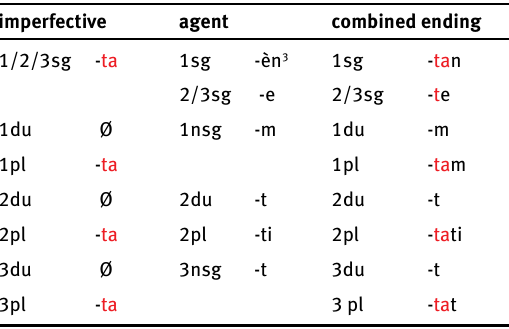
Table 4: Suffixes for the current tenses (immediate and